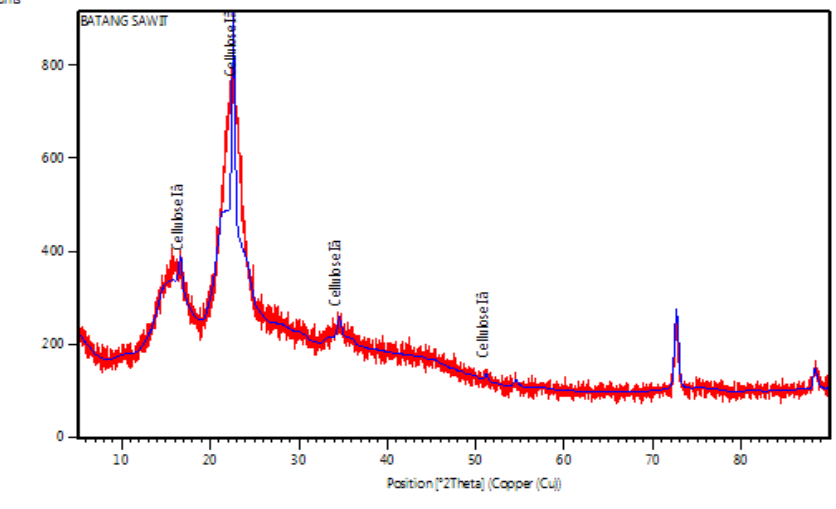
Figure 2. XRD diffractogram of cellulose of OPT